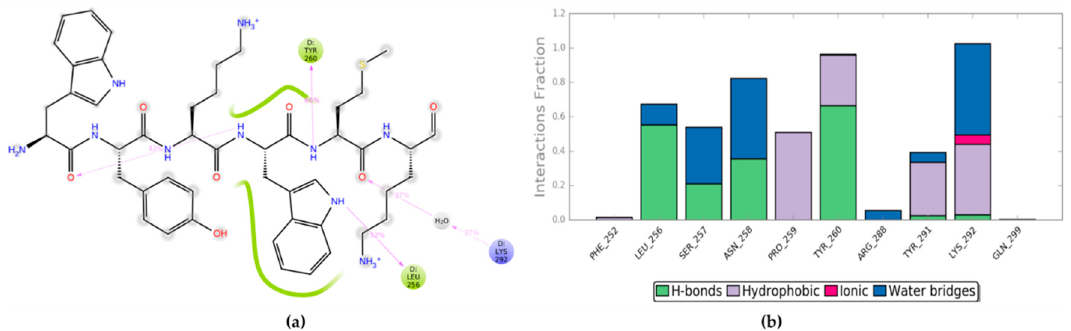
Figure 5. ( a ) Diagram of HTL001 hexapeptide (WYKWMK) interactions with PBX1 residues during MD simulation; ( b ) bar chart of PBX1-HTL00 hexapeptide interaction occurrences during MD simulation.